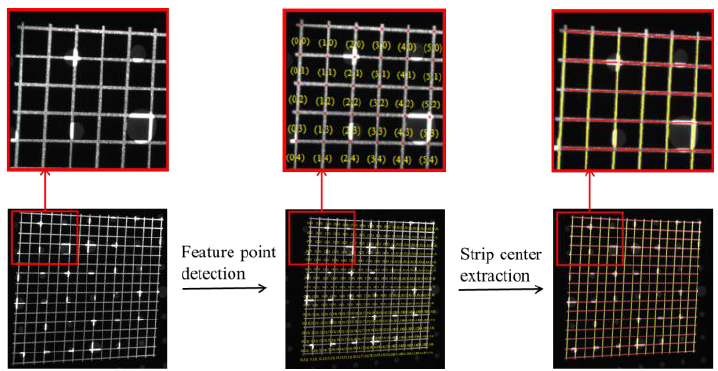
Figure 6. Extraction of grid stripe feature in captured image.